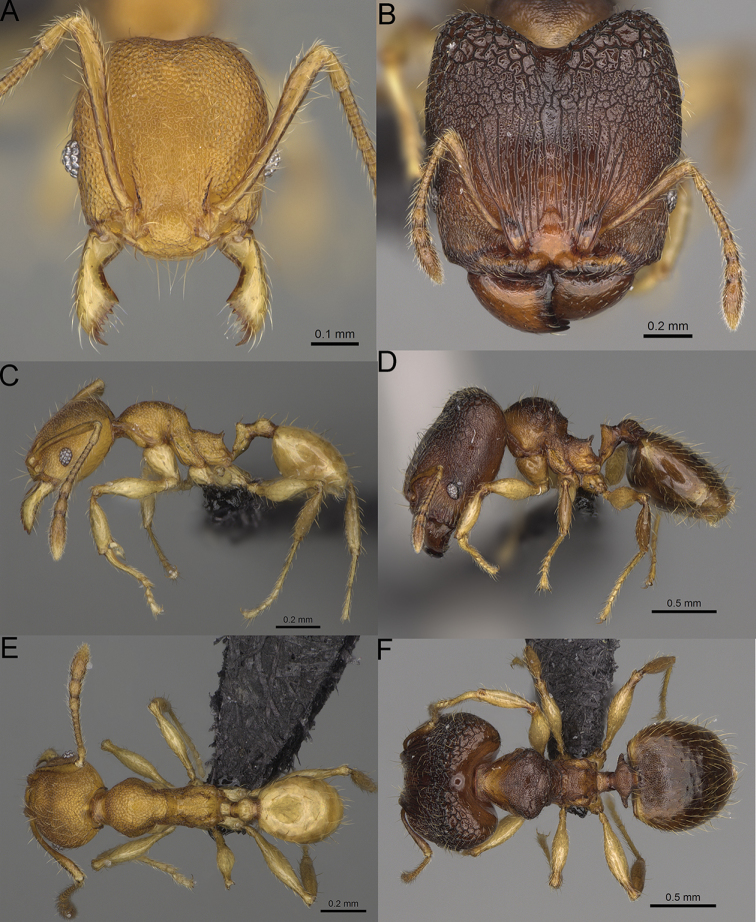
Pheidole
nemoralis Forel, full-face view (A), profile (C), and dorsal view (E) of minor worker (CASENT0430850) and full-face view (B), profile (D), and dorsal view (F) of major worker (CASENT0460136).